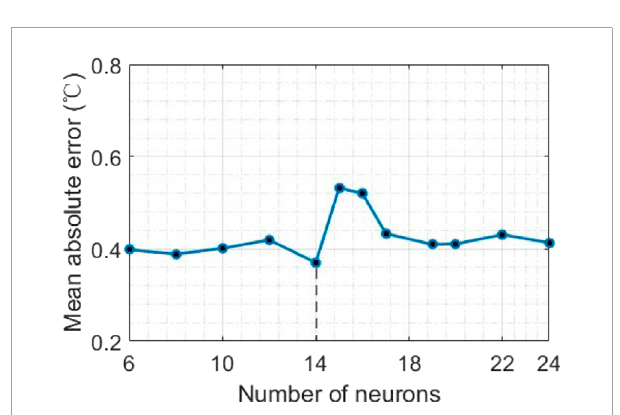
FIGURE 18 MAE vs . the number of neurons in the hidden